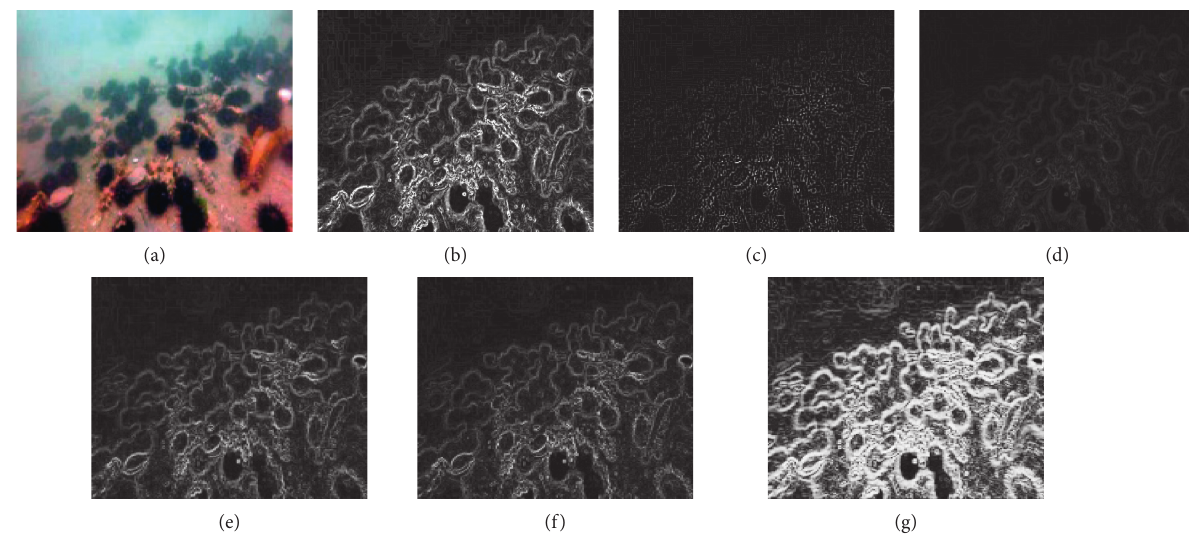
Figure 2: (a) The image of underwater sea urchins; (b) the image of Sobel operator 2-direction edge detection; (c) the image of Laplace operator single-direction edge detection; (d) the image of Prewitt operator 2-direction edge detection; (e) the image of Prewitt operator 4- direction edge detection; (f) the image of Prewitt operator 8-direction edge detection; and (g) the image of Prewitt operator 16-direction edge